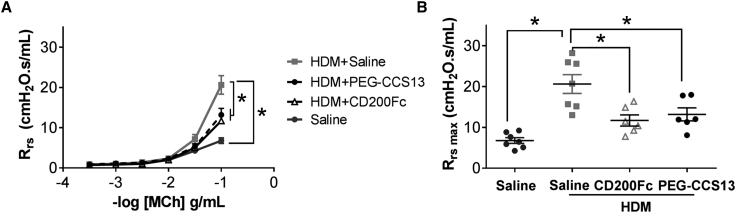
PEGylated Aptamer PEG-CCS13 Suppresses HDM-Induced Allergic Airway Response in BALB/c MiceThe methacholine (MCh) responsiveness of the total respiratory system resistance (Rrs) of BALB/c mice that had undergone a 2-week acute protocol of HDM-induced allergic airways inflammation is indicated and compared following treatment with a single i.v. dose of CD200Fc, PEG-CCS13, or saline. (A) HDM mice exhibited a dose-responsive increase in Rrs in response to increasing doses of inhaled MCh when compared to naive saline control mice (*p < 0.05; n = 6–7 mice per group). Intravenous treatment of the HDM mice with either CD200Fc or PEG-CCS13 significantly abrogated the MCh-induced increase in Rrs, as compared to non-treated HDM mice (*p < 0.05; n = 6–7 mice per group). (B) Reduction in the MCh responsiveness was most obvious at the maximal Rrs value (Rrs max) following treatment with CD200Fc and PEG-CCS13. Each data point represents a mean Rrs value ± SD. *p < 0.05; n = 6–7 mice per group.